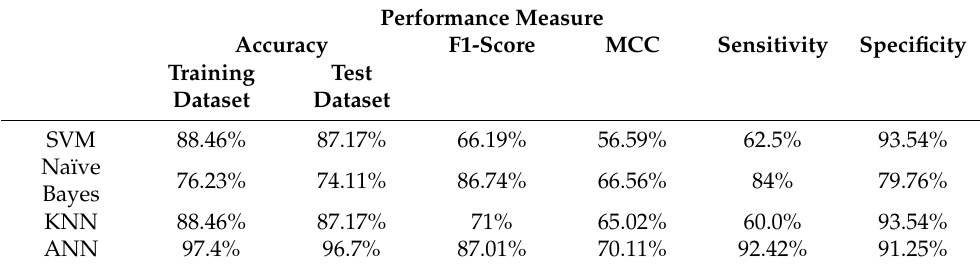
Table 7. An overview of evaluation results.